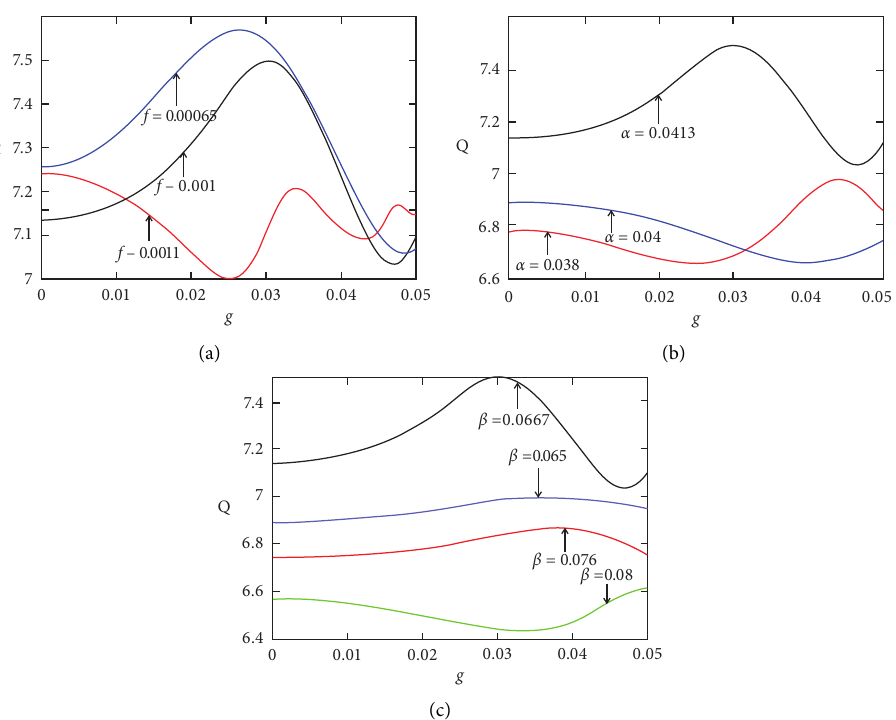
Figure 9: (a) Effect of amplitude f on response amplitude Q versus g with ω � 0.016, Ω � 80 ω , α � 0.0413, and β � 0.0667; (b) effect of nonlinear parameter α on response amplitude Q versus g with ω � 0.016, Ω � 80 ω , β � 0.0667, and f � 0.001; (c) effect of nonlinear parameter β on response amplitude Q versus g with ω � 0.016, Ω � 80 ω , α � 0.0413, and f � 0.001.